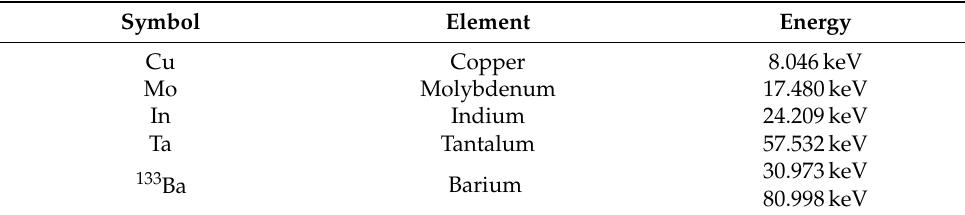
Table 1. List of radiation sources and target materials with their characteristic